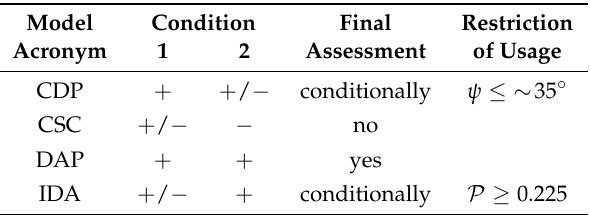
Table 2. Usage range of Willam’s